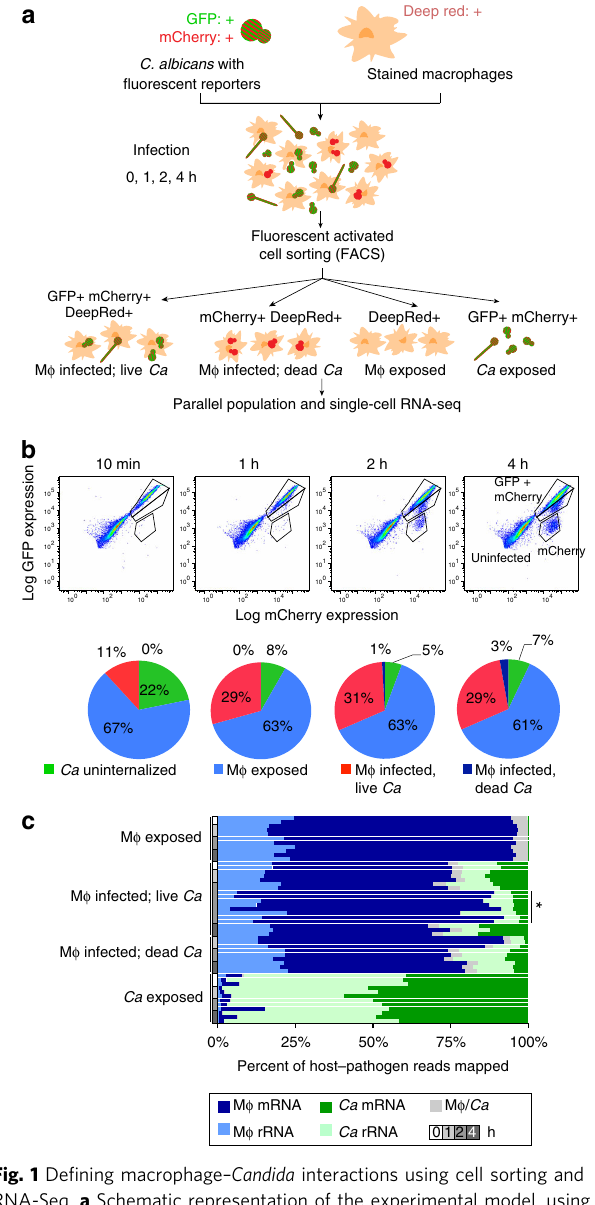
Fig. 1 De fi ning macrophage – Candida interactions using cell sorting and RNA-Seq. a Schematic representation of the experimental model, using primary, bone marrow-derived macrophages (BMDMs) incubated with Candida albicans reporter strain CAI4-F2-mCherry-GFP, sampling at time intervals, and sorting to separate subpopulations of interacting cells. b Bone marrow-derived mouse macrophages (Mø) were incubated with the Candida albicans ( Ca ) reporter strain (Neut5L- NAT1 -mCherry-GFP), then sorted at 10, 60, 120, and 240 min using fl uorescence-activated cell sorting on the BDSORP FACSAria. Pie charts depicting the percent of cells sorted for each infection subpopulation. c Percent of host ( Mø : macrophages) and pathogen ( Ca : C. albicans ) RNA-Seq reads mapped to the composite reference transcriptome, including mouse (GRCm38/mm10; mRNA and rRNA transcripts) and Candida albicans (CAI4-F2; mRNA and rRNA transcripts). Mø/ Ca (gray color label) is the proportion of multiple mapped reads, i.e., reads that map to both the mouse and C. albicans transcriptomes, which were excluded from further